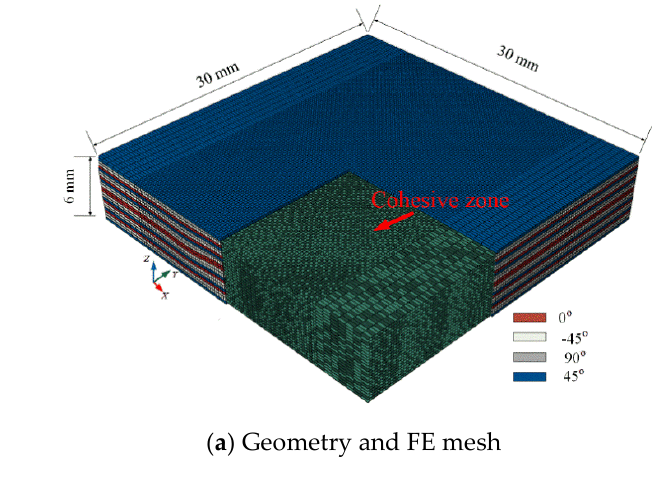
Figure 10. Cohesive models.